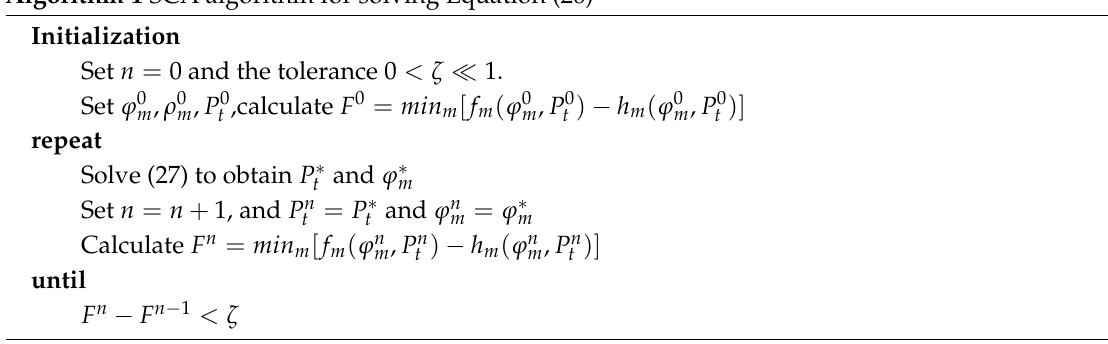
Algorithm 1 SCA algorithm for solving Equation